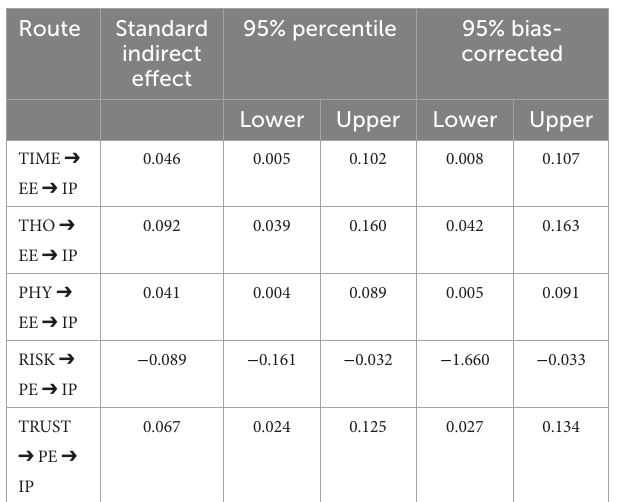
TABLE 11 The mediation analysis results.